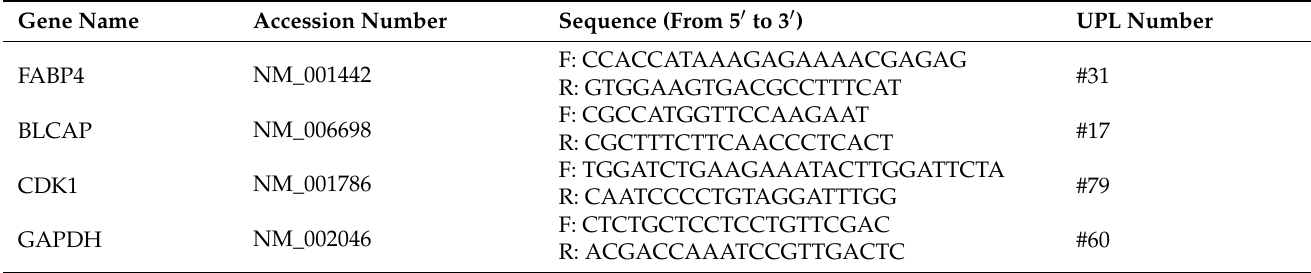
Table 1. Primer sequences and probe numbers for real-time